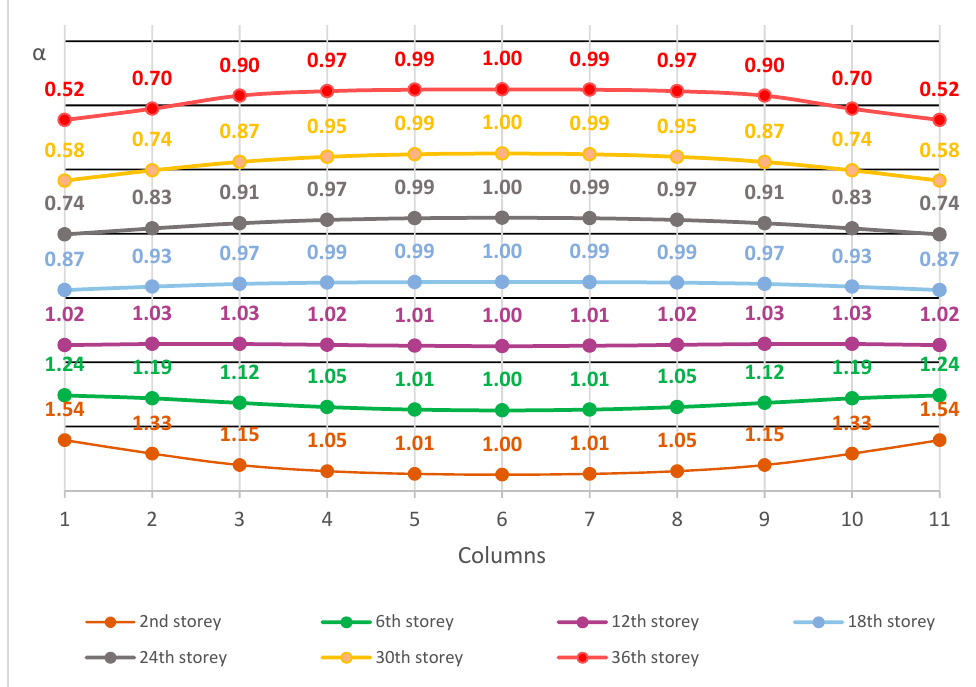
Figure 7. Shear lag effect on seven characteristic storeys in the flange panel (panel parallel to the panel on which the horizontal loads act).